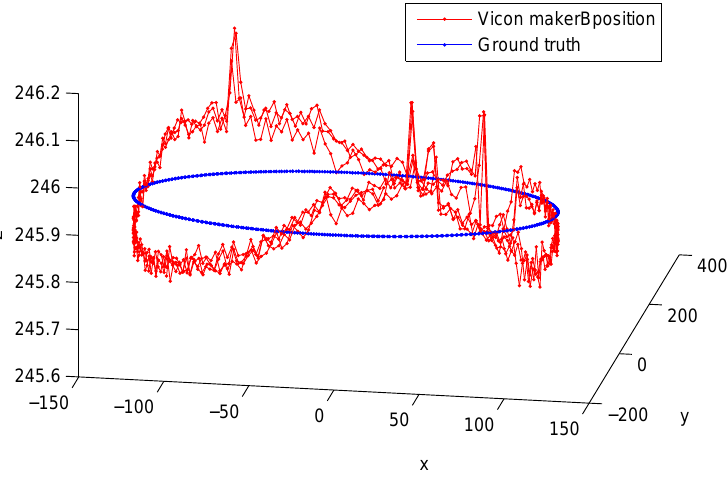
Figure 8. Marker B trajectory from dataset 1 and ground truth (axis in millimeters).